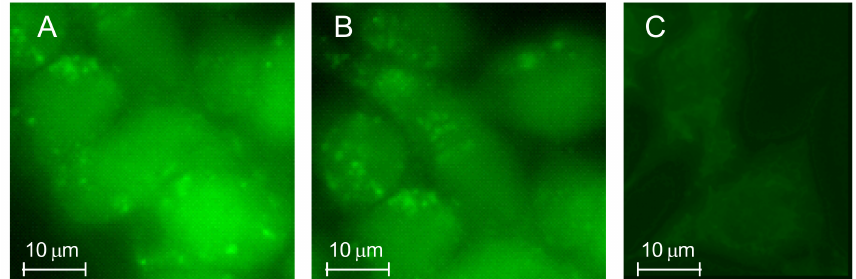
Figure 12. Rat C6 glioma cells were treated at 37 ◦ C in a 5% CO 2 atmosphere with 5 µ M of TSPO–FITC–Dex NGs 10 ( A ) or TSPO-FITC-Dex NGs 11 ( B ) and the internalized fluorescence was imaged after 24 h of treatment. Images were obtained from 3 to 5 independent experiments and identical fields are presented. Untreated cells and cells treated with 5 µ M FITC–Dex alone (after 24 h) were used as a control ( C